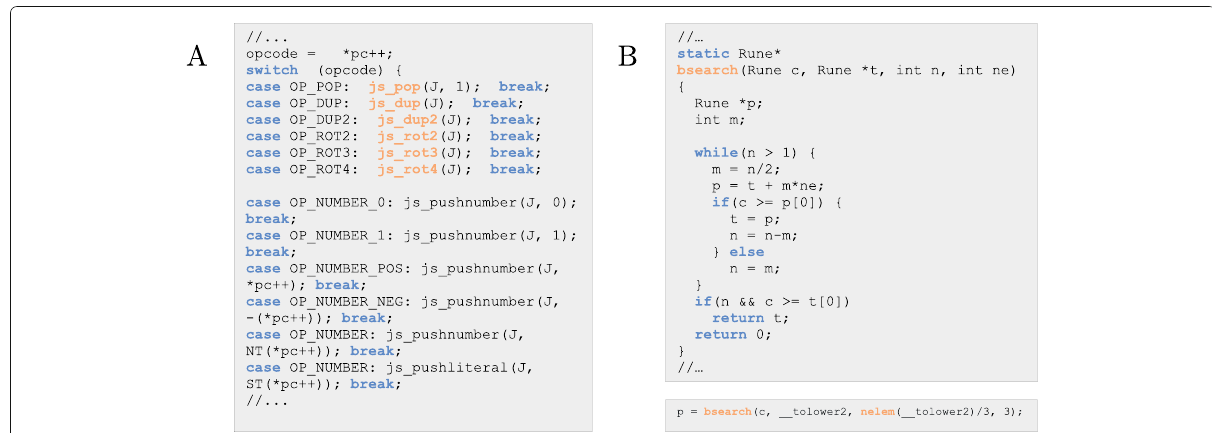
Fig. 5 Disadvantage of Third-party Packages for Confidentiality Management in Enclaves. Direct port of commodity software may leave additional side-channel traces which ruins the confidentiality guarantees of the hardware. a ) Excerpt showing the Input Dependent Control Flow in js_run method of jsrun.c in MuJS interpreter. b ) Excerpt showing the Input Dependent Data Access in bsearch method of utftype.c in MuJS interpreter. (Both Accessed on May 2018